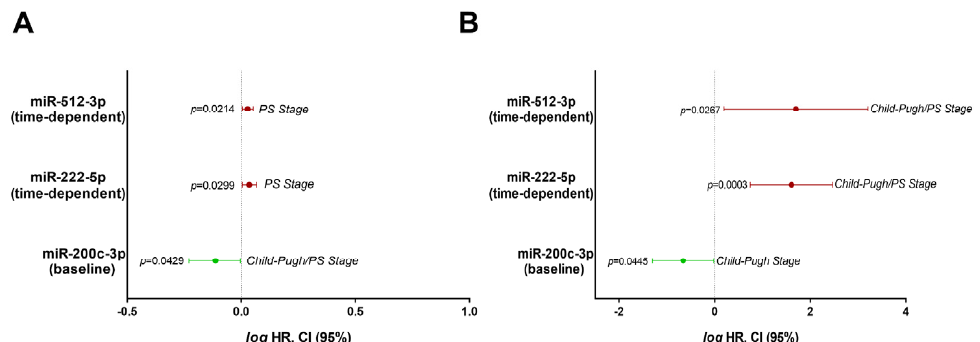
Figure 5. Hazard ratio models of circulating miRNAs coincident in two independent patient cohorts as prognostic factors of patient death. ( A ) Death risk models of miR-200c-3p (baseline levels), miR-222-5p (time-dependent values), and miR-512-3p (time-dependent values) in the study cohort (BCLC-C, n = 27). ( B ) Death risk models of miR-200c-3p (baseline levels), miR-222-5p (time-dependent values), and miR-512-3p (time-dependent values) in the validation cohort (BCLC-C, n = 47). Results are expressed in the logarithmic scale as the hazard ratio and 95% confidence intervals.